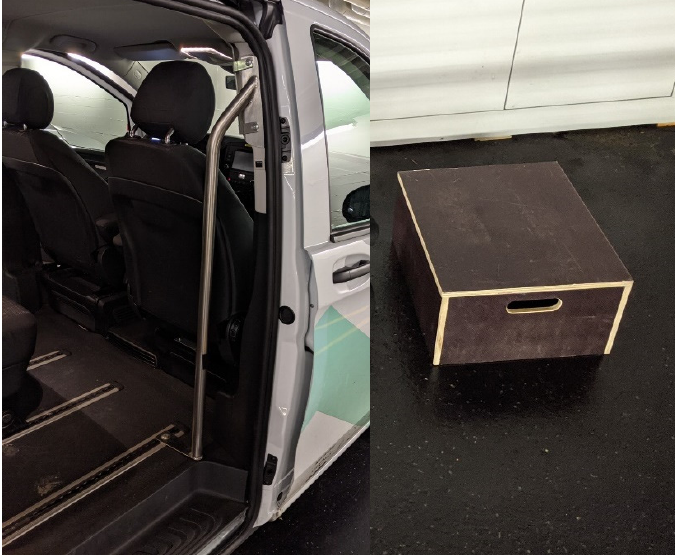
Figure 3. Necessary conversions because conventional series-production vehicles do not fully meet the required specifications (image rights are held by Pikmi (VBZ)). The provider in Zurich carried out the conversion work in 2021 after it had consulted on the suitability for everyday use in an internal workshop.